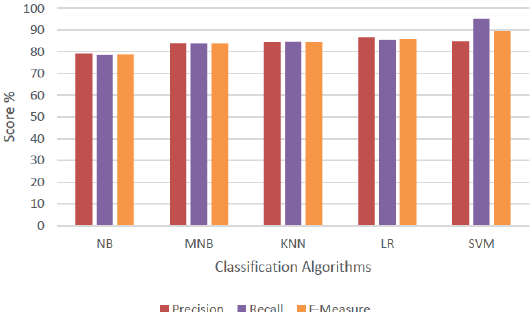
Figure 6: Sentiment prediction for